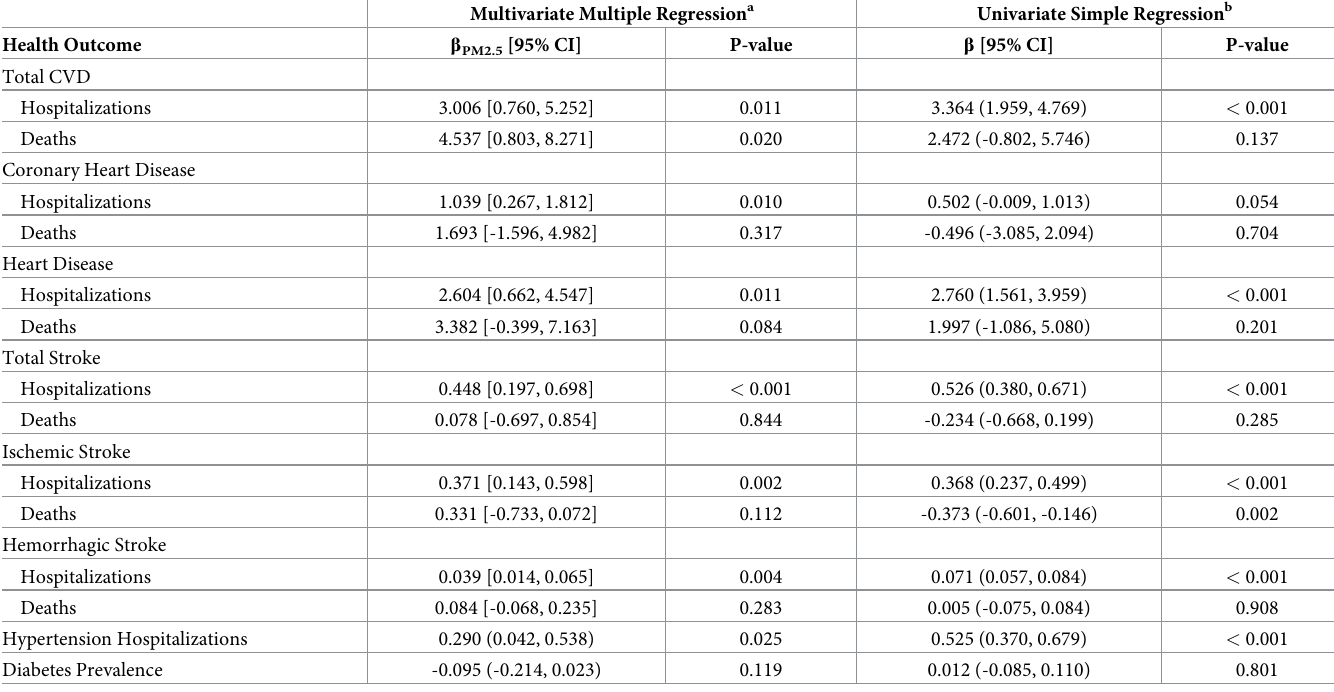
Table 1. A summary of the results of the regression analyses. Regression coefficient ( β ) for PM 2.5 is shown for each regression model, as well as the p-value for each var- iable. P-value < 0.05 is considered a statistically significant association. Column a shows results of multivariate multiple regression for hospitalization/death rates as well as multiple regression results for diabetes prevalence. Coefficients of confounding variables in the models are not shown. Colum b shows results of univariate simple regres- sion with respect to each disease outcome variable, with PM 2.5 concentration as the explanatory variable. Multivariate Multiple Regression a Univariate Simple Regression